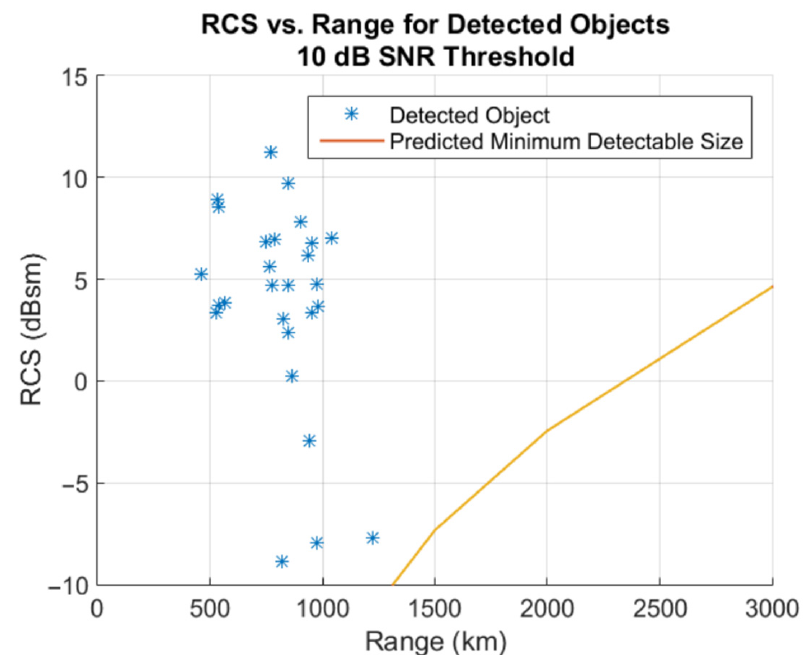
Figure 6. Scatter plot of RCS vs. range for the detected objects with respect to the minimum detectable size by the BIRALET system. SNR, signal-to-noise ratio.